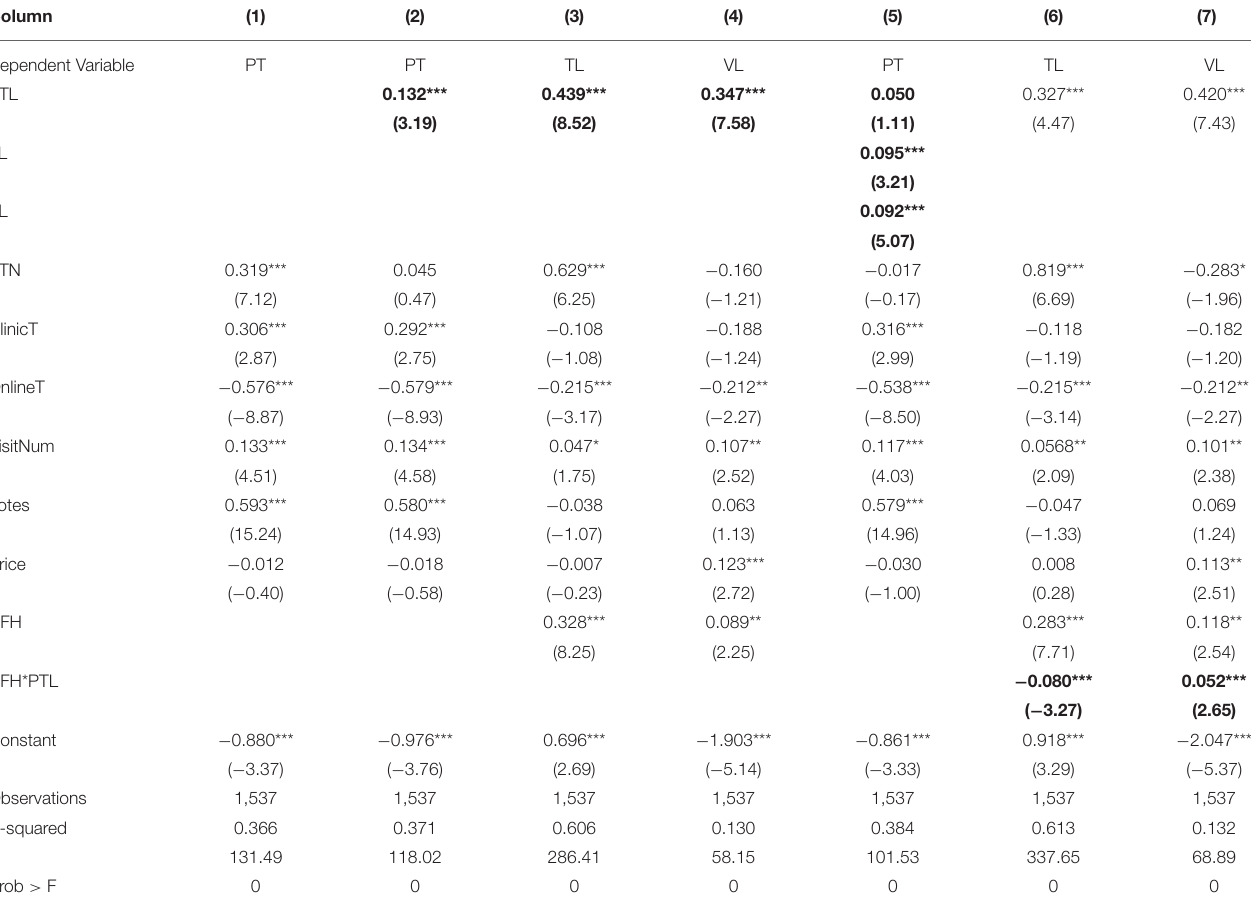
TABLE 5 | Estimated results.